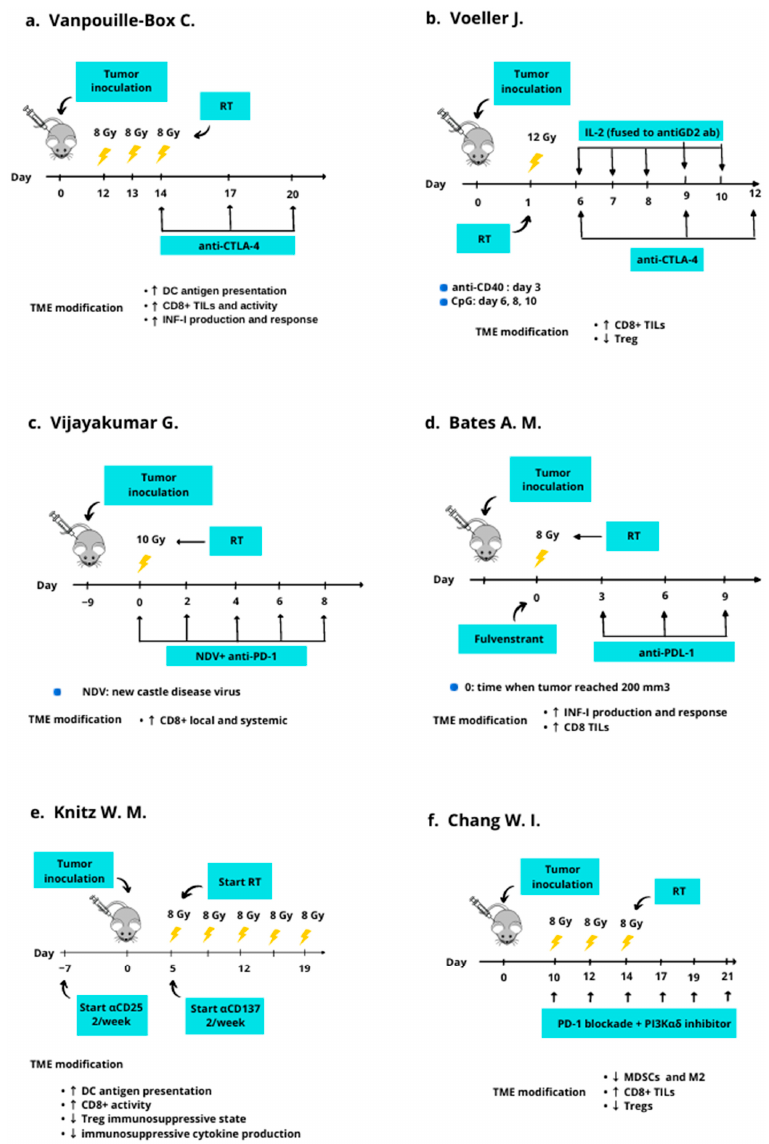
Figure 2. Summary of the experimental protocols associated with the most promising result of preclinical studies of TME radiomodulation and IT. The authors highlighted these combinations as the most effective for switching a cold TME into a hot one, and for increasing tumor response to IT. The figures display the RT schedules (dose/fraction) and the IT tested, as well as the timing of combination. Furthermore, the TME modifications provoked by the treatment are also reported under each figure. ( a – f ) The most effective combination of TME radiomodulation and IT tested by Vanpouille-Box et al. [22], Voeller et al. [27], Vijayakumar G. et al. [28], Bates et al. [29], Knitz et al. [30], and Chang et al. [31],